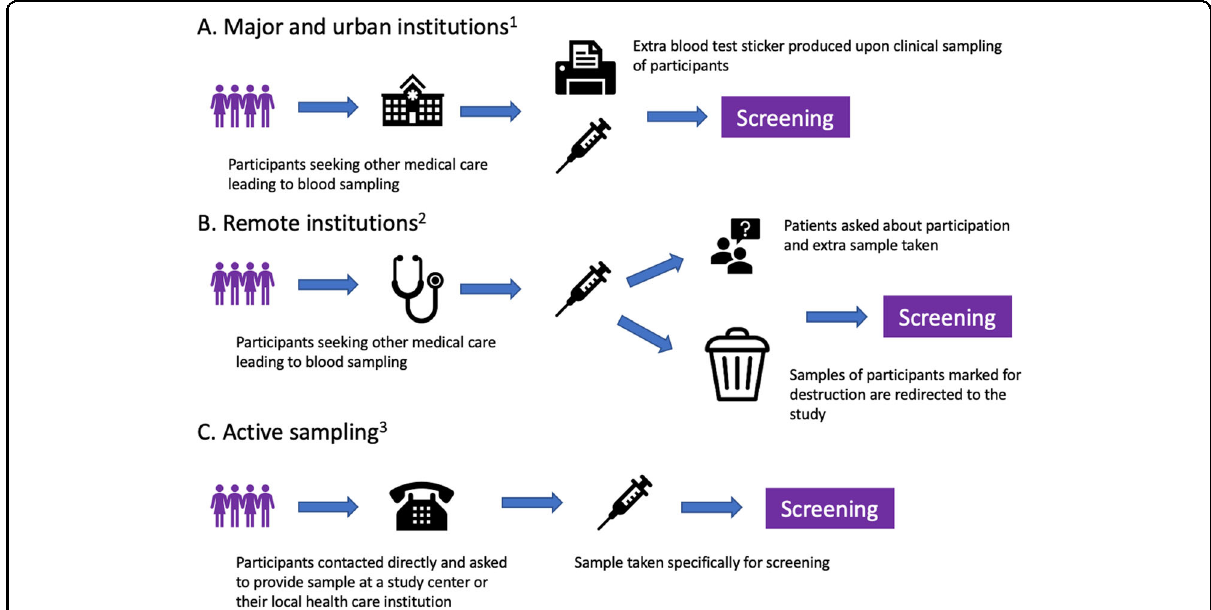
Fig. 1 Methods of blood sample acquisition. A and B describe passive sampling starting during the fall of 2016, and C describes active sampling beginning during the fall of 2019. 1: Reykjavik Capital Area, Akureyri, Ísafjörður, Reykjanes Peninsula, Akranes, Healthcare Institution of Northern Iceland, Healthcare Institution of South Iceland, blood banks 2: Neskaupsstaður, Healthcare institution of West Iceland, Healthcare Institution of East Iceland. 3: Available for all Icelandic